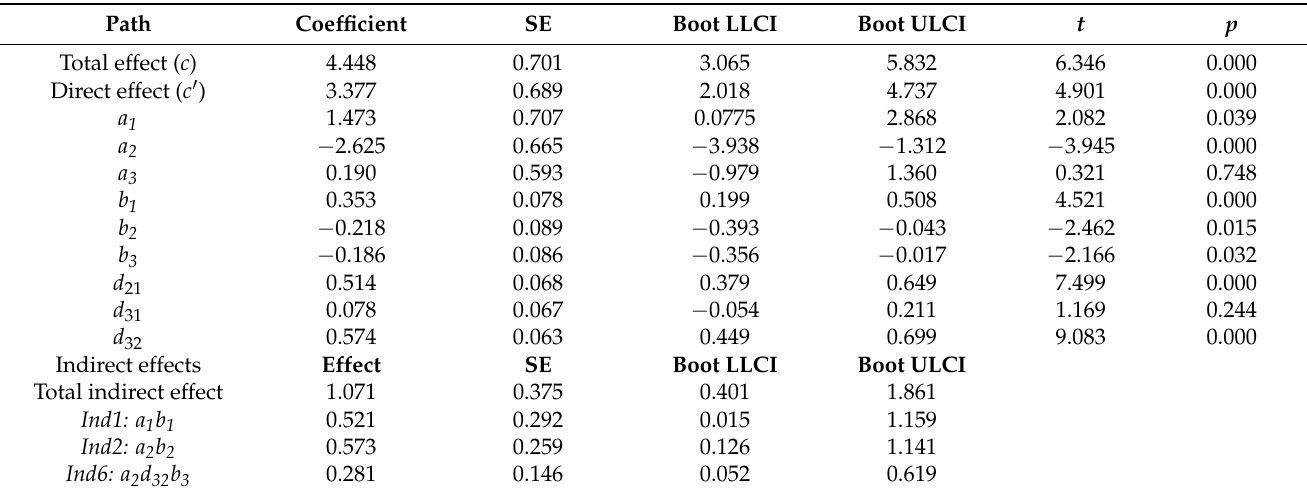
Table 2. Results of the analysis evaluating serial mediation of Emotional Intelligence in subjective sleep quality and depression, including sex and age as covariates.